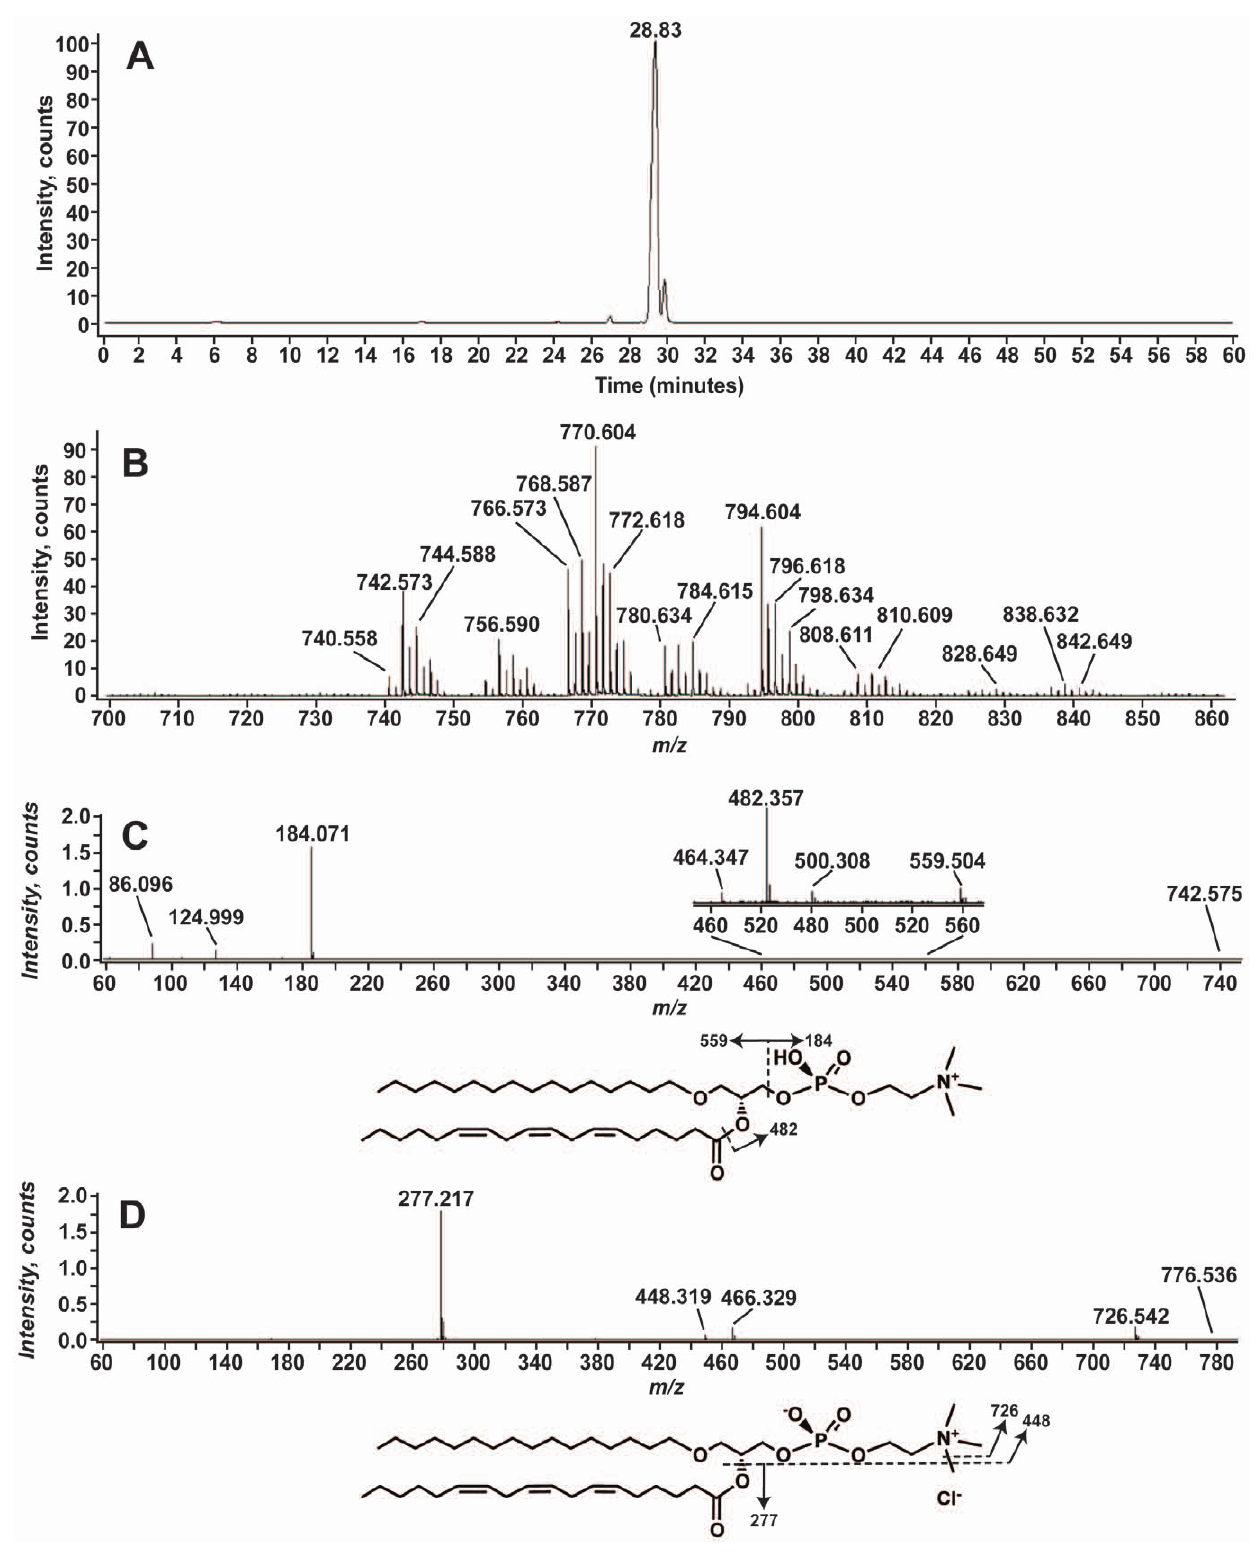
Figure 6. Alkyl-phosphatidylcholines identified in A.pallida . Panel A shows the EIC of the [M + H] + ion at m/z 770.6. Panel B shows the positive- ion mass spectrum from m/z 700 to 860 for the lipids eluting between 28.9 and 30.1 Minutes. Panel C shows the positive-ion MS/MS spectrum. The aPC predicted from this spectrum and the exact mass is shown with selected product ions indicated. Panel D shows the negative-ion MS/MS spectrum with the major product ions are indicated on the aPC structure shown below.